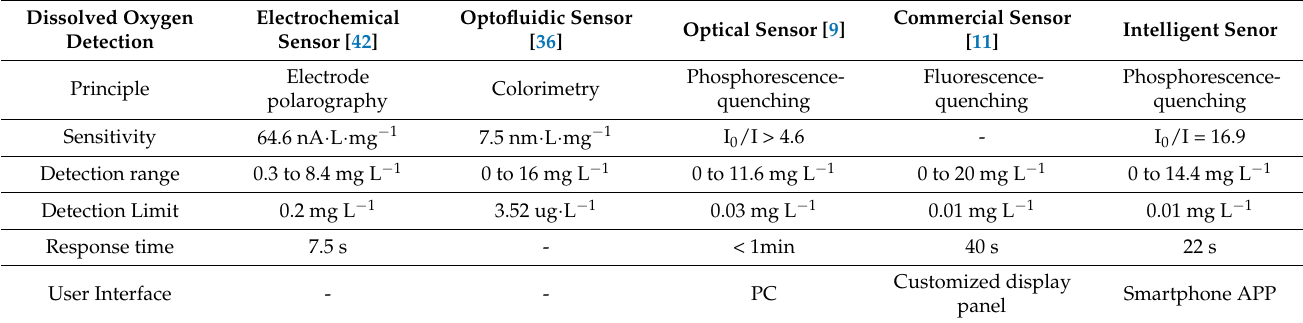
Table 1. Comparison of the intelligent DO sensor with other DO detection techniques. Dissolved Oxygen Electrochemical Detection Sensor